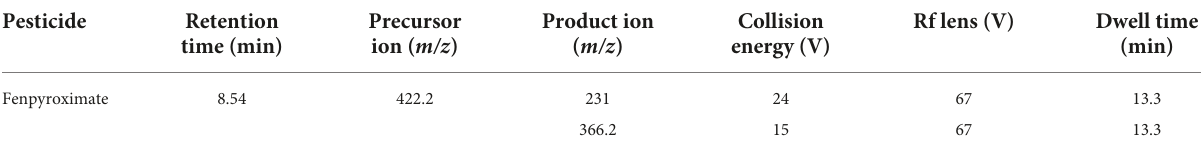
TABLE 1 Liquid chromatography–tandem mass spectrometry (LC–MS/MS) parameters for determination of fenpyroximate.